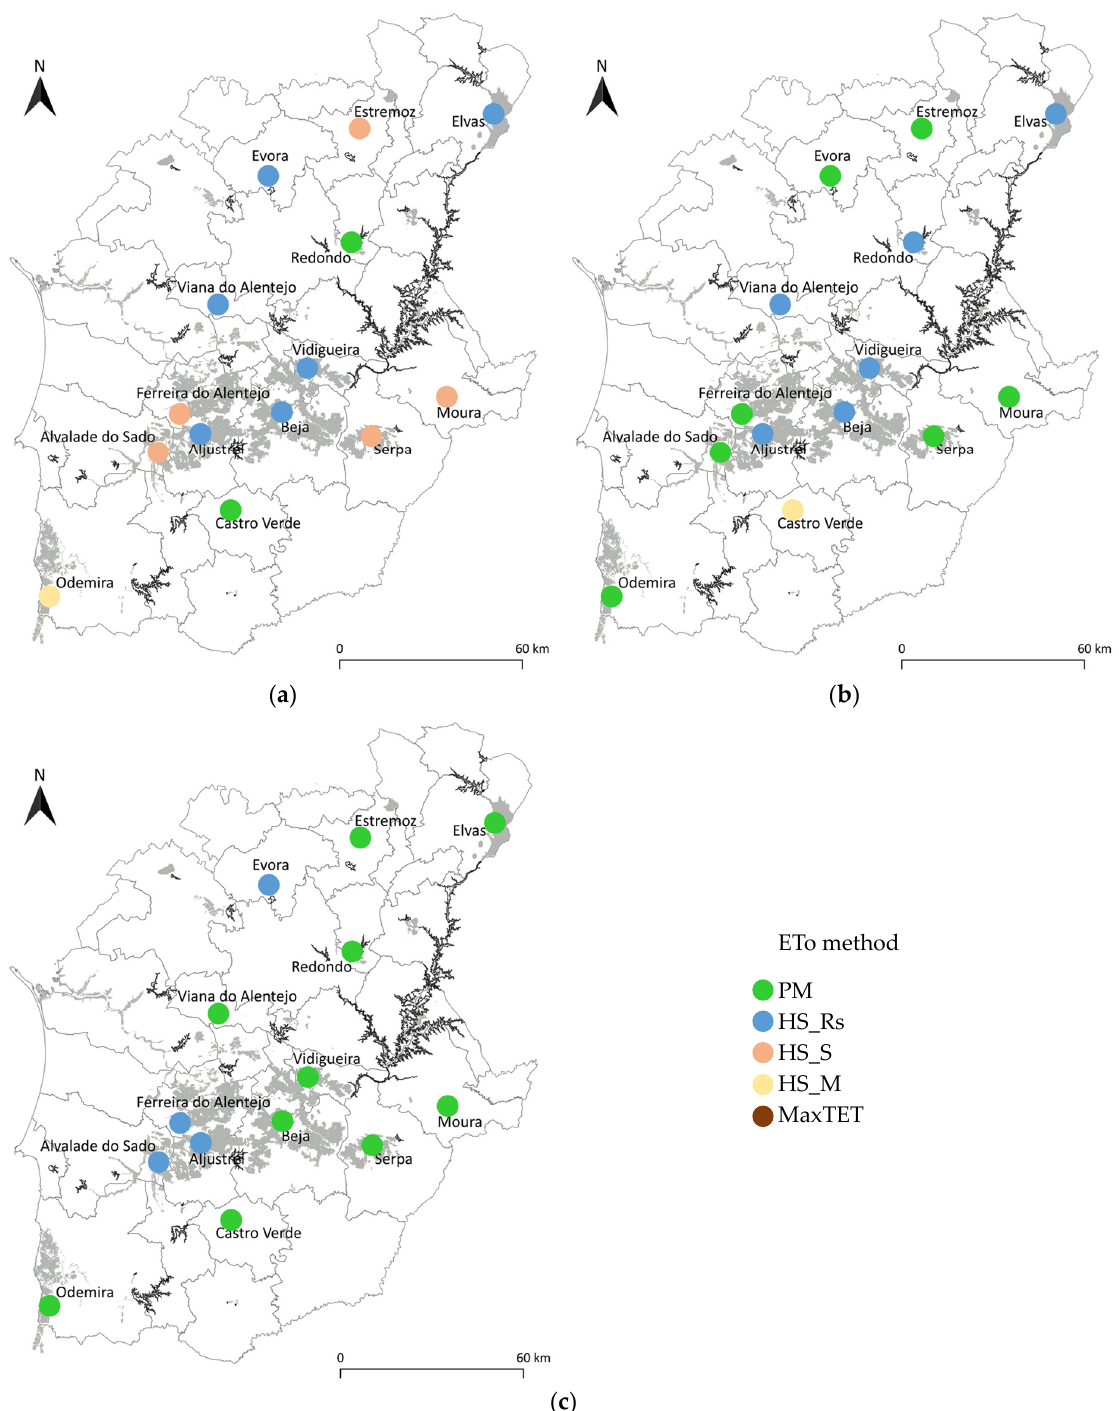
Figure 3. Most accurate daily ETo estimation method for each location with ( a ) uncorrected bias, ( b ) regional bias correction and ( c ) local bias correction.